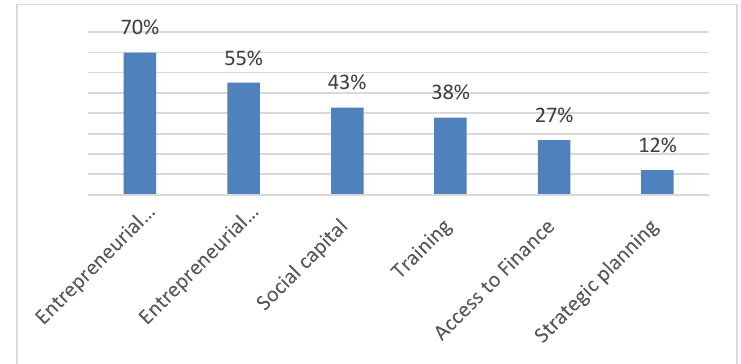
Figure 15: Key Success Factors ; Source: